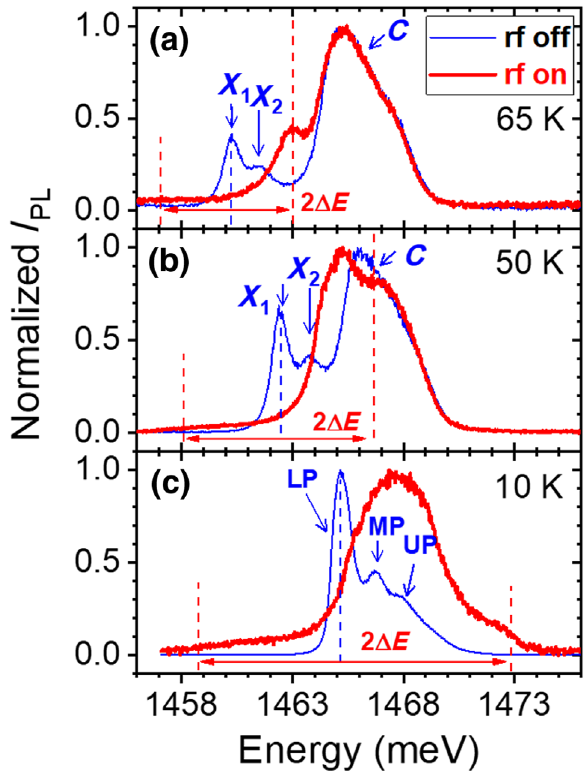
FIG. 6. Modulation of polaritons by MC acoustic modes. Time- averaged PL spectra of sample A recorded in the absence (thin blue lines) and in the presence (thick red lines) of a BAW with ¼ 6 . 931 GHz recorded at (a) 65, (b) 50, and frequency f BAW (c) 10 K. Δ E denotes the energy modulation amplitude of the excitonic levels in (a) and (b), and polariton states in